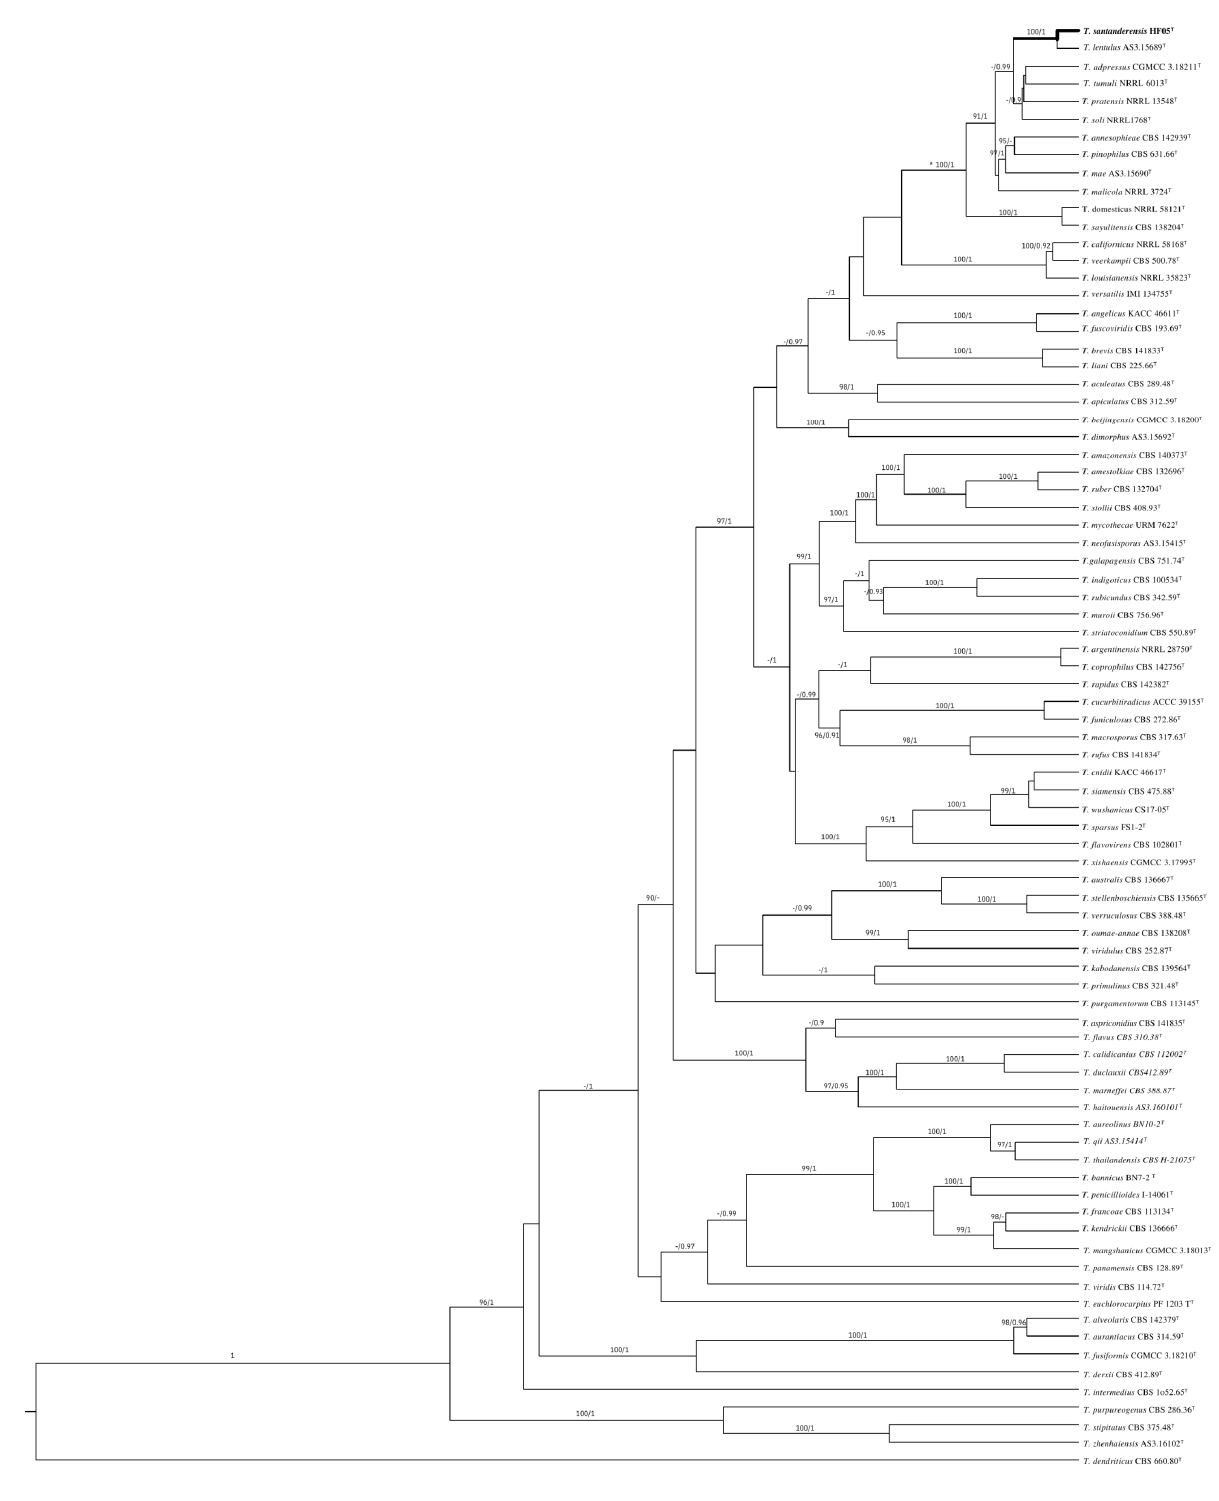
Figure 4. Topologies reconstructed with ITS, CaM, BenA and RPB2 , bootstrap and posterior probability included at the nodes. BI phylogram inferred from the concatenated BenA-CaM-RPB2 sequences. Ultrafast-bootstrap percentages over 90% derived from 10,000 replicates and posterior probabilities over 0.9 of posterior support are indicated at the nodes. T indicates ex-type strains, strains belonging to new species are indicated in boldface. Scale Bar: number of substitutions per nucleotide